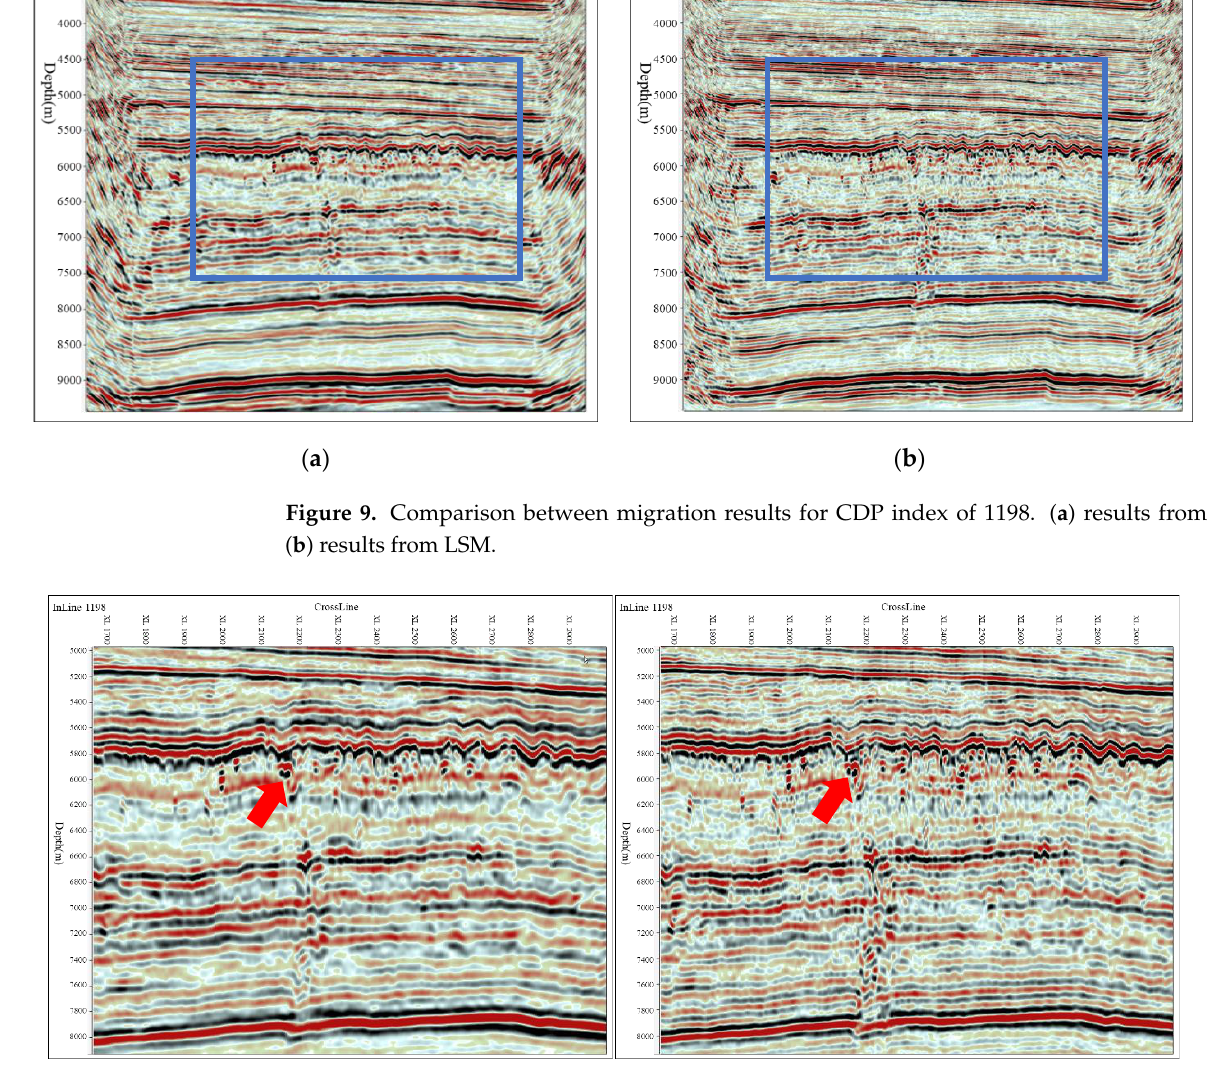
Figure 10. Locally zoomed-in reservoir sections marked in Figure 9. ( a ) results from RTM; ( b ) results from LSM.